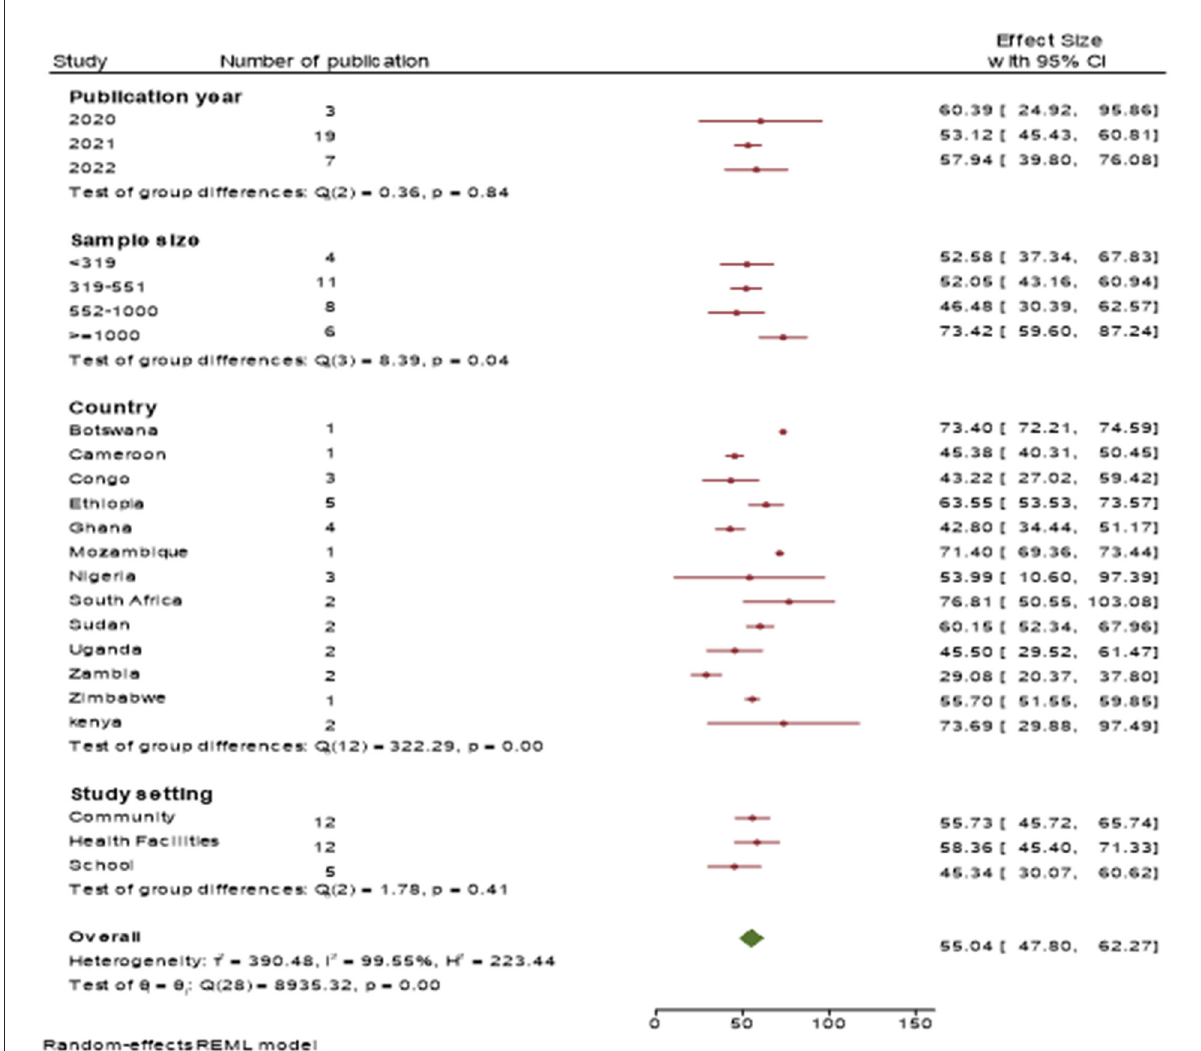
FIGURE5 Forest plot showing the pooled prevalence of COVID-19 vaccine acceptance among the study population through subgroup analysis by sample size, country, study setting, and publication